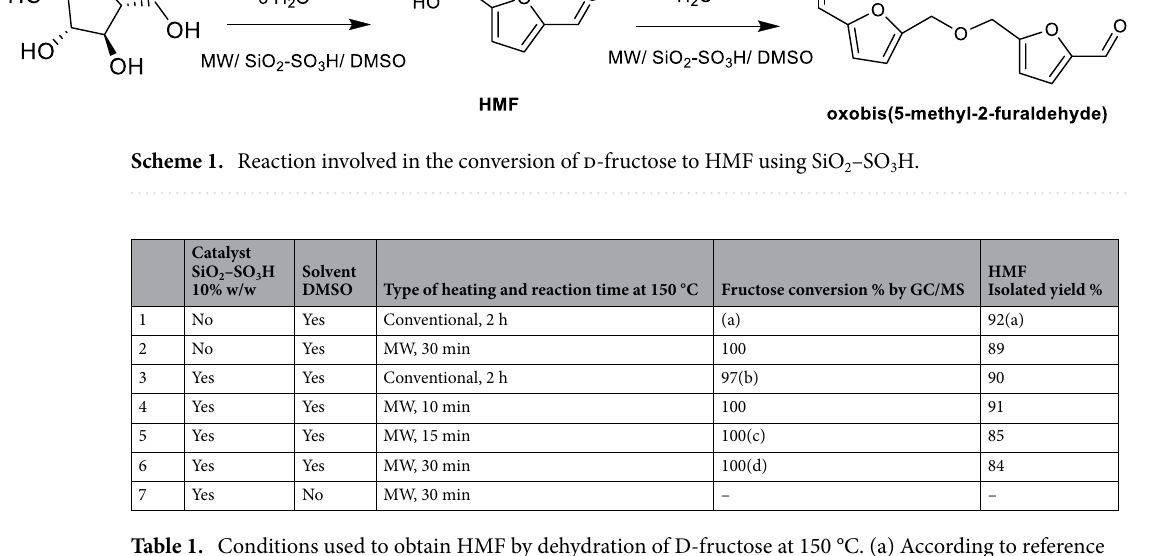
Table 1. Conditions used to obtain HMF by dehydration of D-fructose at 150 °C. (a) According to reference 36, plus 1.2% oxobis(5-methyl-2-furaldehyde); (b) 3% recovered fructose; (c) 98% plus 2% oxobis(5-methyl-2- furaldehyde); (d) 95% plus 5% oxobis(5-methyl-2-furaldehyde).